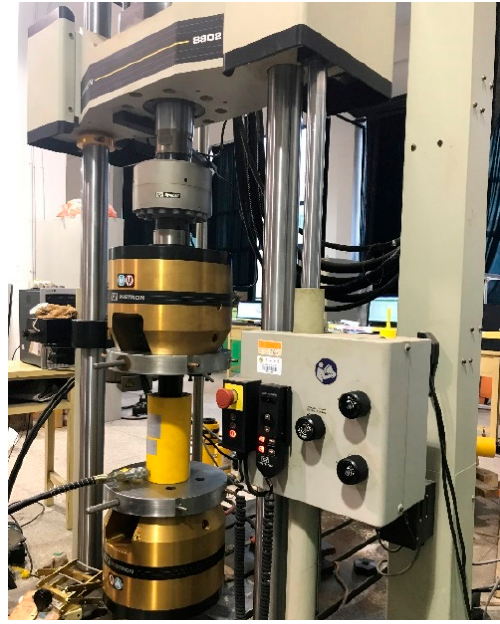
Figure 4. Fatigue testing machine—INSTRON 8802.